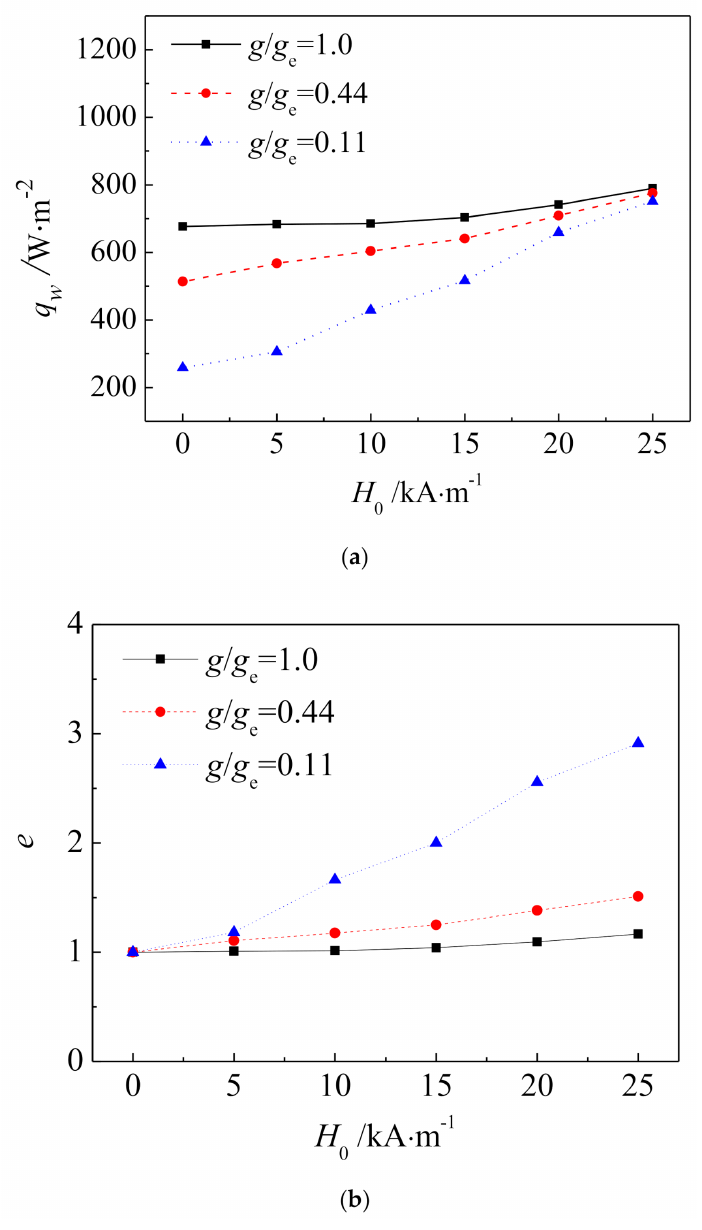
Figure 16. Variations of the ( a ) averaged heat flux and the ( b ) heat flux enhancement ratio under the non-uniform magnetic field (see Figure